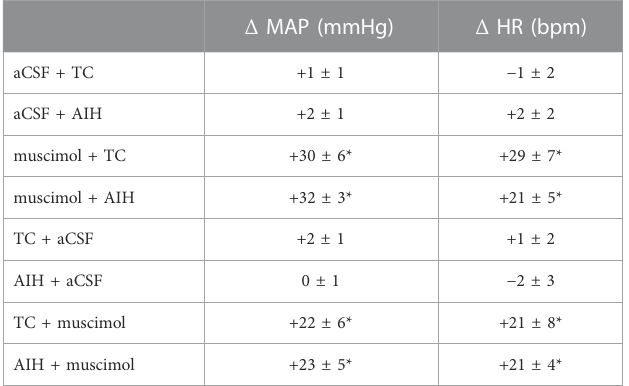
TABLE 3 MAP and HR response to nTS inhibition with muscimol. Peak changes were calculated relative to baseline immediately before injection of either muscimol or aCSF. Values are means ± SEM. p ≤ 0.05, * compared to baseline before injection, paired t -test. One-way repeated measures ANOVA indicates changes due to muscimol were similar before or after AIH or TC, p >